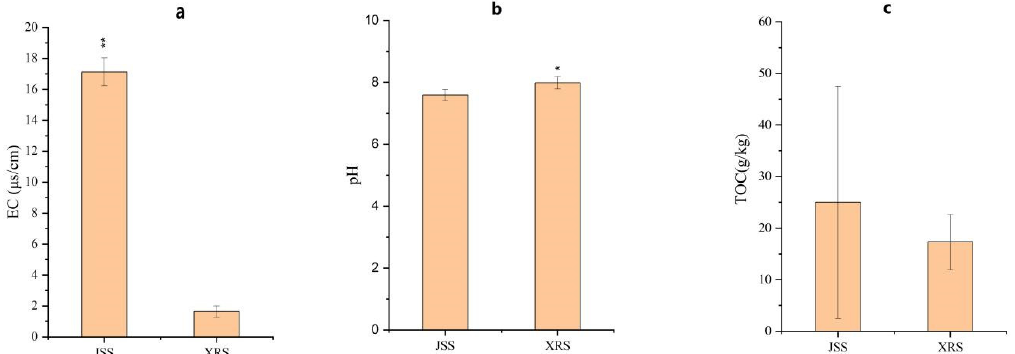
Figure 1. Soil physicochemical parameters. ( a ) Electrical conductivity (EC); ( b ) pH; ( c ) total organic carbon (TOC). One asterisk (*) represents significant difference ( p < 0.05) and two asterisks (**) represent highly significant difference ( p < 0.01) between treatments. JSS: the bulk soil sample; XRS: soil of the P. sibiricum rhizosphere.